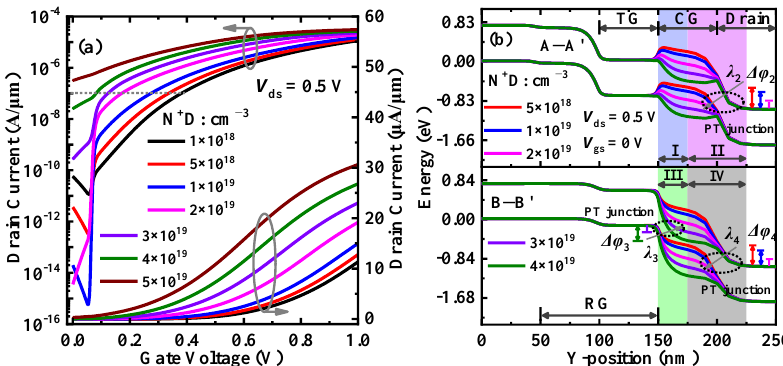
Figure 6. ( a ) Transfer characteristics and ( b ) energy band profiles along A–A’ and B–B’ in the OFF- state, for DGNP-EHBTFET with N + D = 5 × 10 18 ~4 × 10 19 cm −3 .